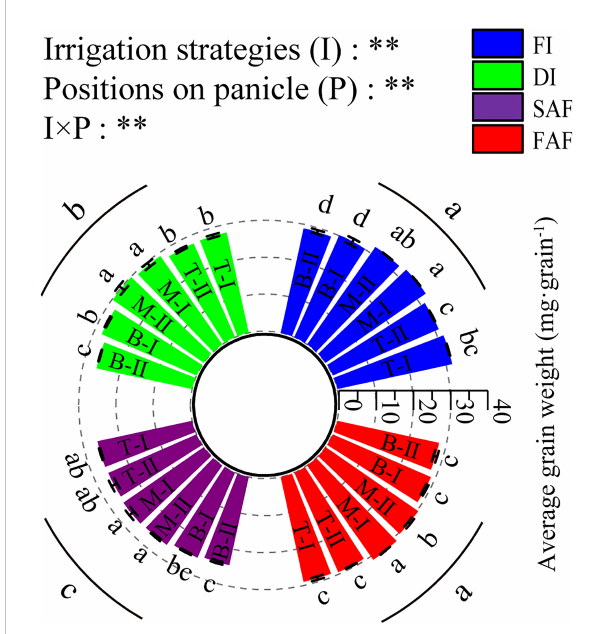
FIGURE 3 Average grain weight on different positions of panicles. The vertical line on the column represents three repeated standard errors. Different letters represent signi fi cant difference among treatments (P< 0.05). The Least-Signi fi cant Difference Test (LSD) was used for comparison. ANOVA of treatment (T) and positions of panicle (P) and their interaction (T × P) (**P<0.01). FI, the whole growing season fl ooding; DI, the whole growing season normal drip irrigation (soil relative moisture (RSM) was maintained in a range of 90 – 100%); SAF, pre-anthesis normal drip irrigation and post-anthesis water stress (the RSM was maintained in a range of 80 – 90% after anthesis); FAF, pre-anthesis normal drip irrigation and post-anthesis fl ooding; T, M and B represent the top, middle and bottom of the panicles respectively, and the Roman numerals I and II represent the primary and secondary branches respectively.